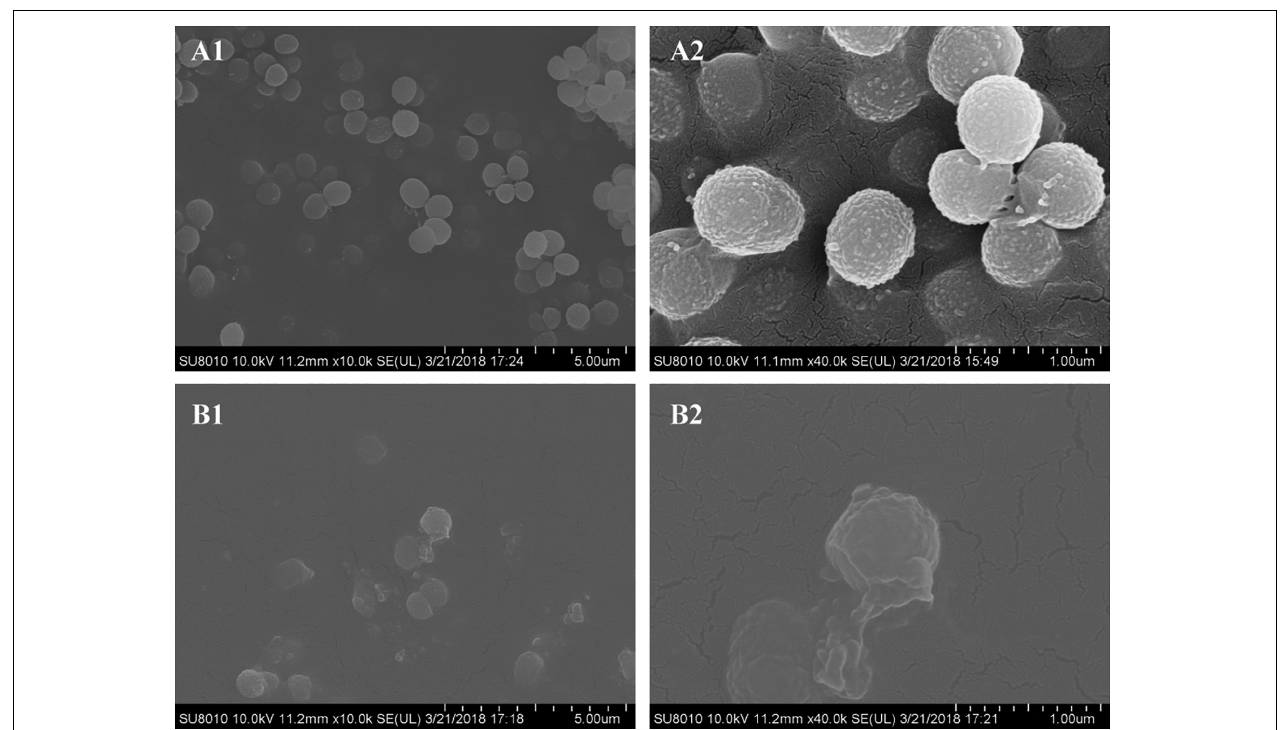
FIGURE 4 | Scanning electron microscopy images of biofilms formed by Staphylococcus epidermidis following 12 h of treatment with 16 µ g/mL aloe-emodin. Treatment without (A) and with aloe-emodin (B) . A2 and B2 show higher magnifications than A1 and B1 , respectively. Scale bars of 5 µ m and 1 µ m are shown at the bottom right of the panels marked (A) and (B) , respectively, with each scale bar equally divided into 10